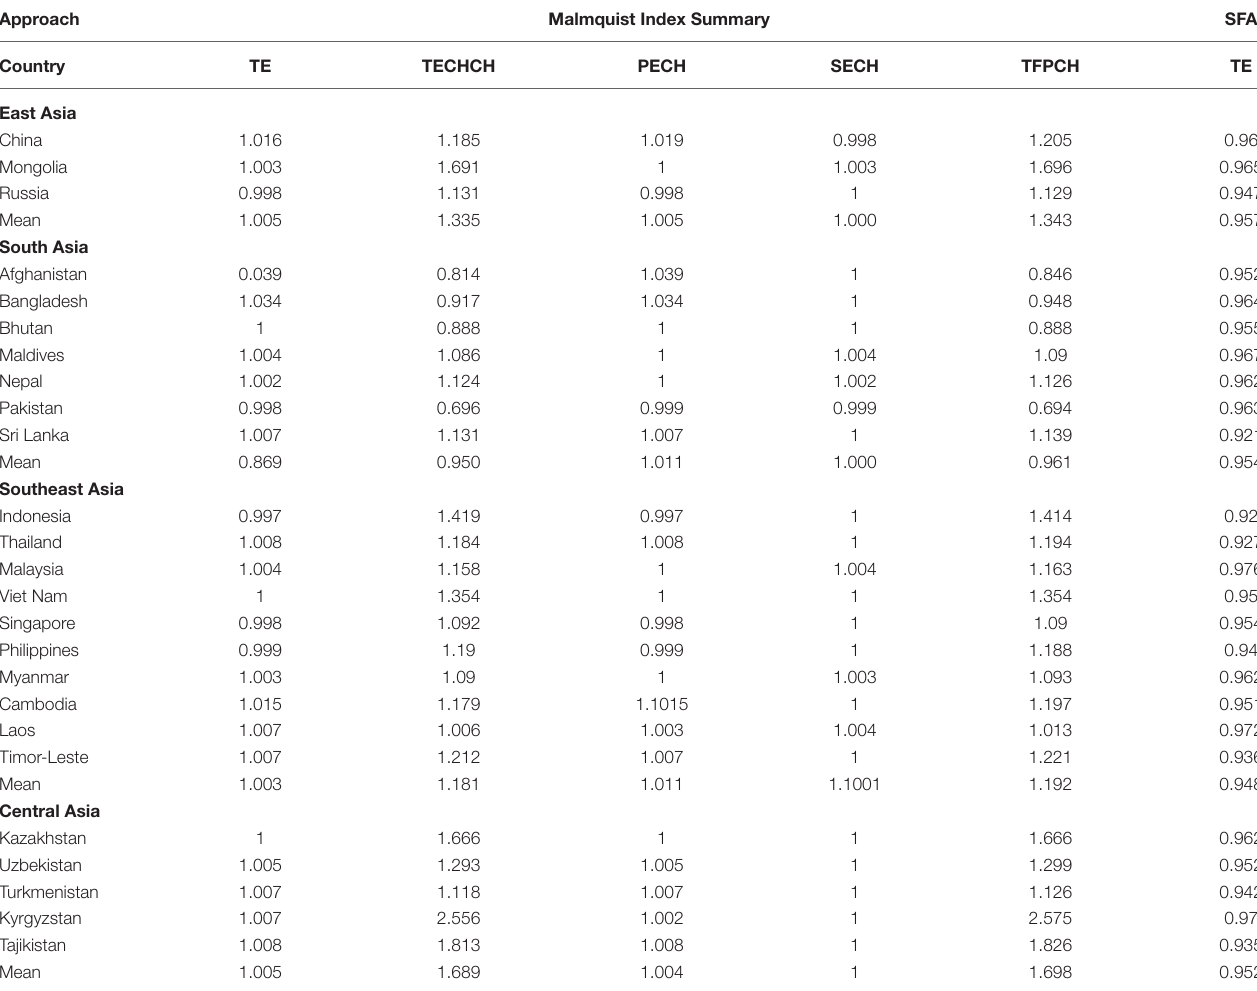
TABLE 3 | Countries’ economic efficiency